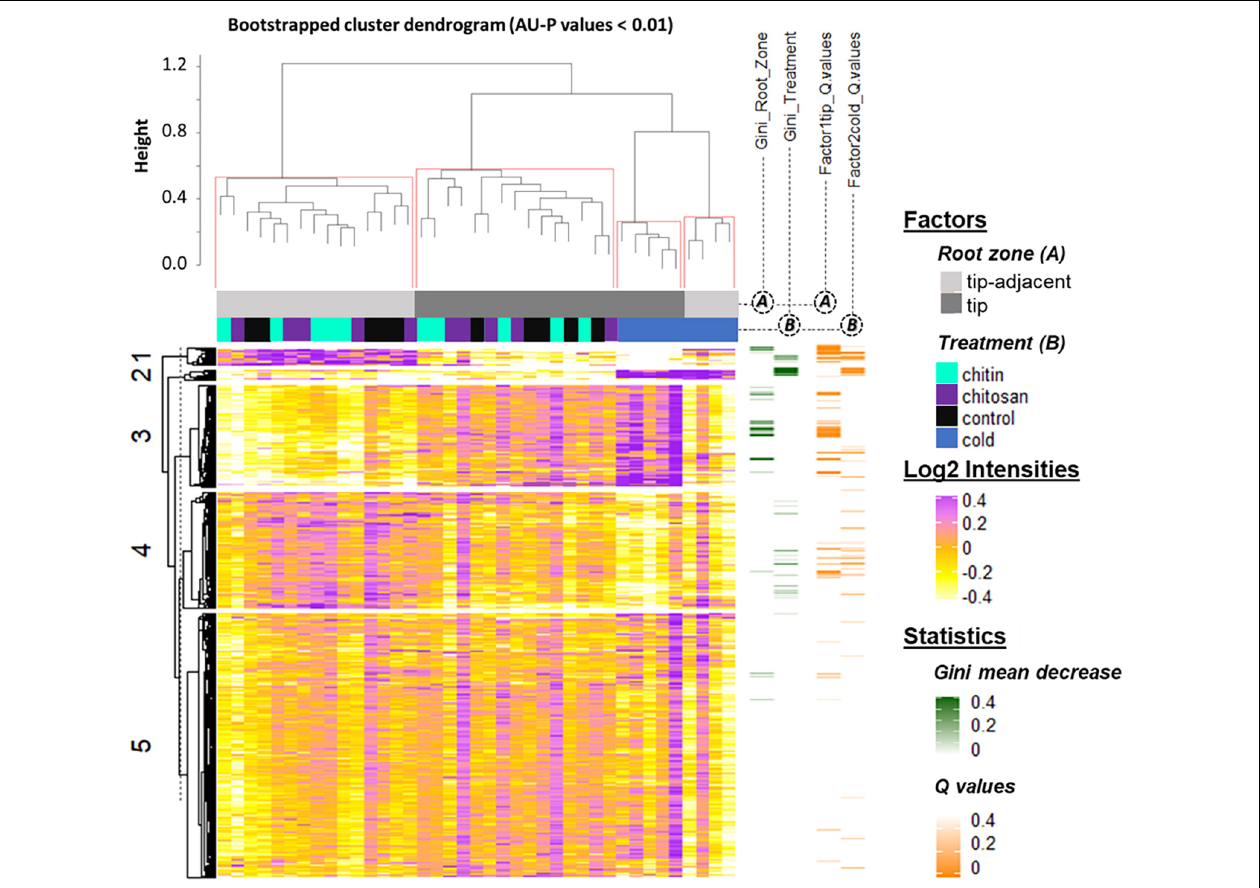
FIGURE 4 | Summary log 2 -heatmap of statistical methods applied for class comparison, class discovery, and class prediction in LC-MS ( n = 5). See also Supplementary Figures 3, 5, and Supplementary Table 4 . Abscissa and ordinates were clustered using hierarchical cluster analysis (HCA) with Pearson correlation as distance measurement and average distance as clustering method. The clusters were bootstrapped, and approximately unbiased probability values (AU- P ) values were calculated (red squares in the top cluster; see in Supplementary Table 4 the clustered ordinates). Additionally, to aid interpretation, K-means clustering was performed in the ordinates and indicated by numbers from 1 to 5 to the left side of the clusters. Response variables were tested for homoscedasticity and normality. Non-parametric tandem mass tag (TMT)-corrected protein intensity distributions from Hordeum vulgare roots (detailed in Supplementary Table 4 ) were evaluated ( Supplementary Figure 5 ) by functions of the GitHub repository RandoDiStats (https://github.com/MSeidelFed/RandodiStats_package). Subsequently, an appropriate link function was selected to fit a generalized linear model (GLM). P values were adjusted into Q values using the FDR-BH95’. Orange colored rows in the third heatmap to the right indicate Q values < 0.05 in treatments that constituted a differential proteome. Finally, a random forest (Wiener and Liaw, 2003) analysis with default parameter settings was used to find markers suitable to predict the main factors of variance in the dataset, i.e., the classification of the two root zones and all treatments compared with cold. The green heatmap to the right contains the mean decrease Gini coefficient; a larger (dark-green) decrease means greater contribution of respective protein to predict sample classifications.